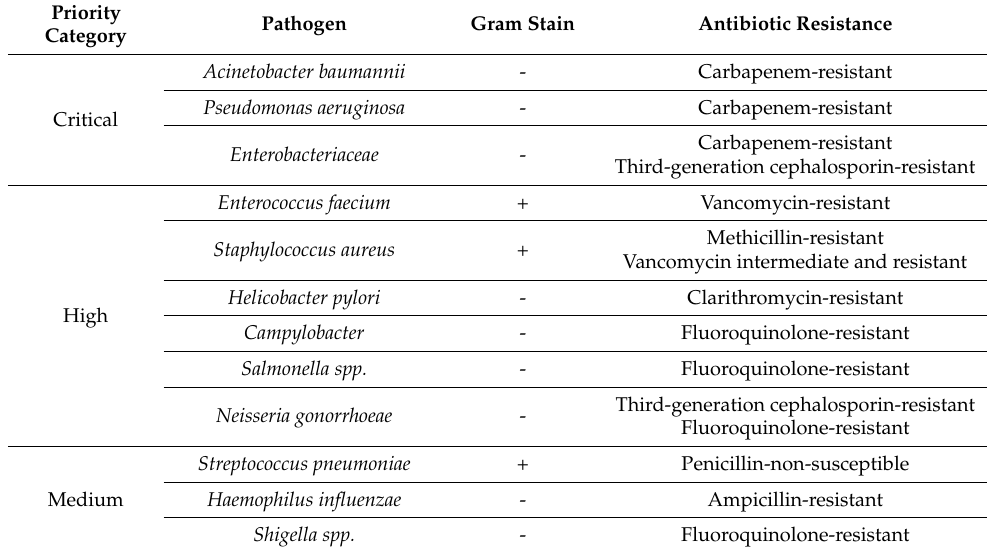
Table 1. WHO list of global priority